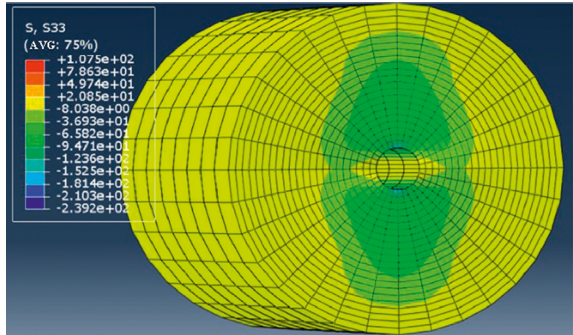
Figure 26: Stress cloud of intermediate layer S33 in 400% com- pression shear condition.